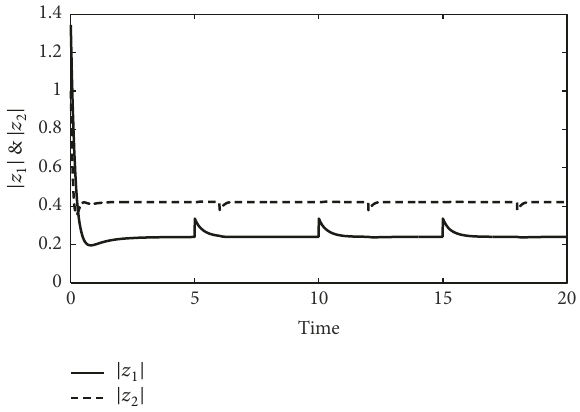
Figure 5: State curves of |𝑧 1 | and |𝑧 2 | with impulsive disturbances.